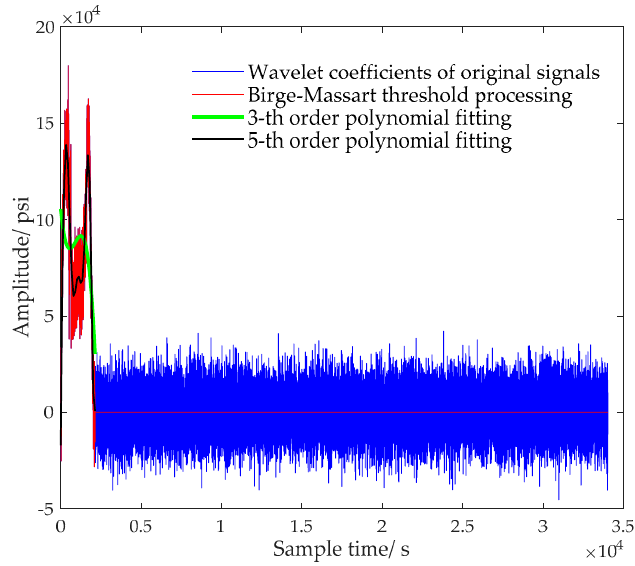
Figure 9. The distribution of wavelet coefficients under different reconstruction methods.